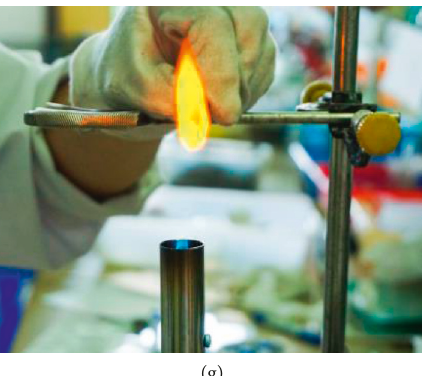
Figure 2: (a–f) Glass fiber mat after flammability tests of the mixed solutions at wt.% of EMI-TFSI in EC-PC (1 :1) with 1M NaTFSI; (g) IL during exposure to flame. Table 1: The mean values of the self-extinguishing time (SET) of several mixtures of IL and EC-PC (1 :1) with 1M NaTFSI. Electrolytes